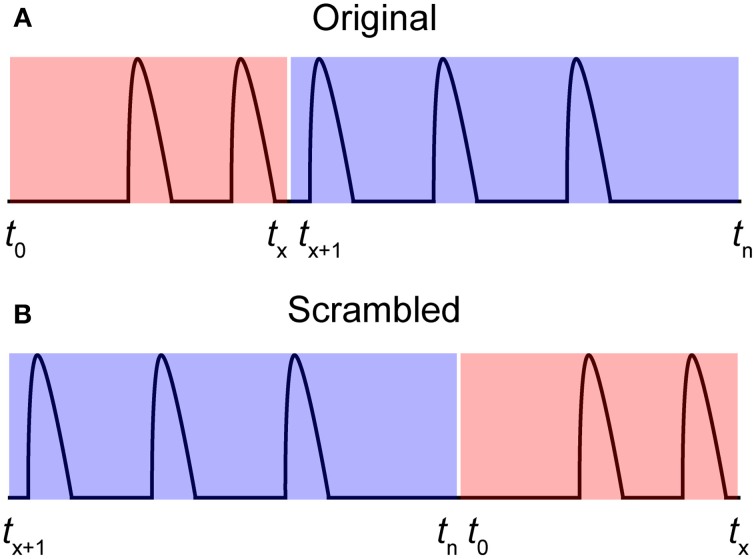
Producing a scrambled signal. (A) A pseudo-signal with start and end time points t0 and tn. (B) A scrambled signal was created by shuffling the signal in (A) to a random time point tx.